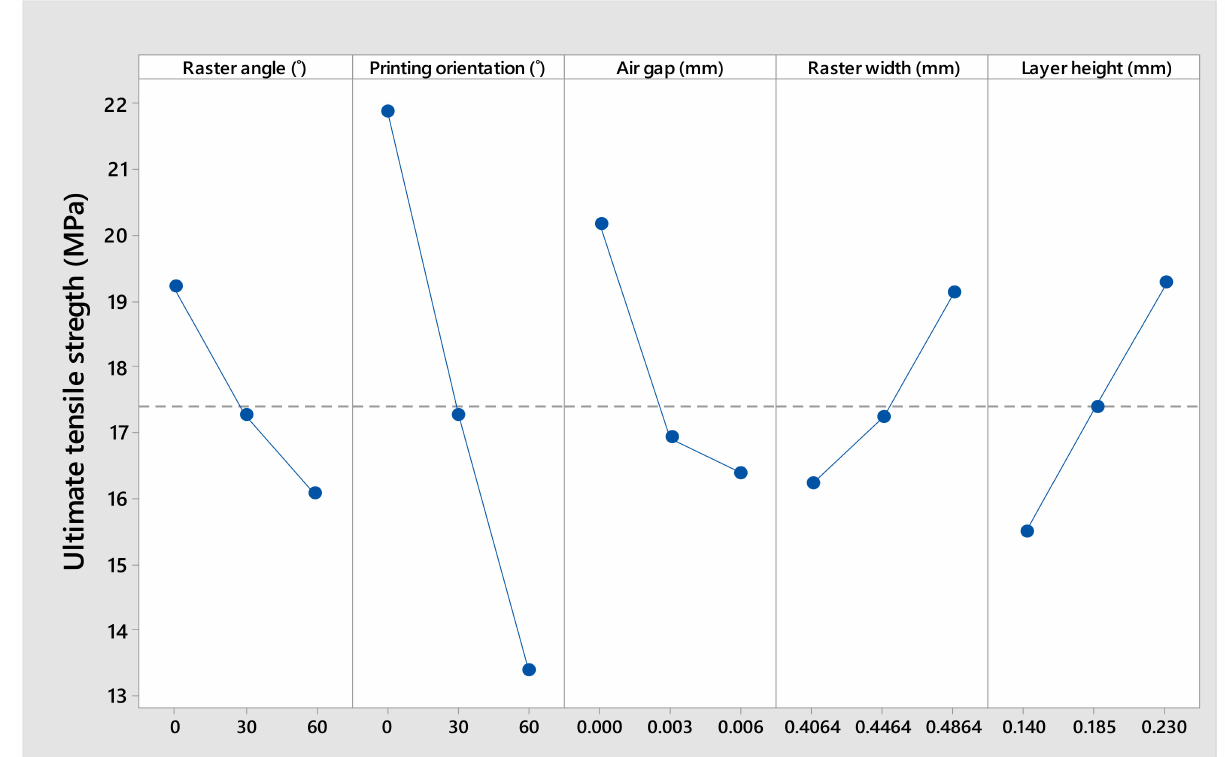
Figure 5. Main effect plots of UTS for means with all process